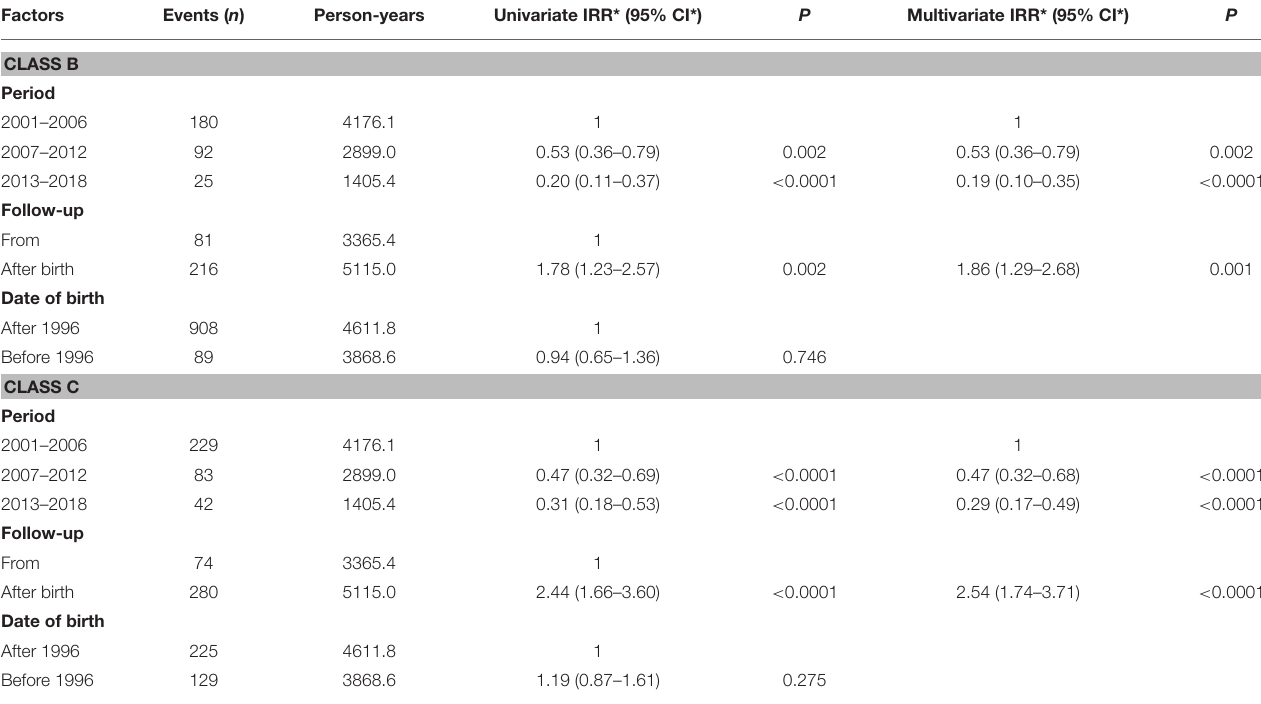
TABLE 5 | Class B and C event rates among the study periods adjusted for